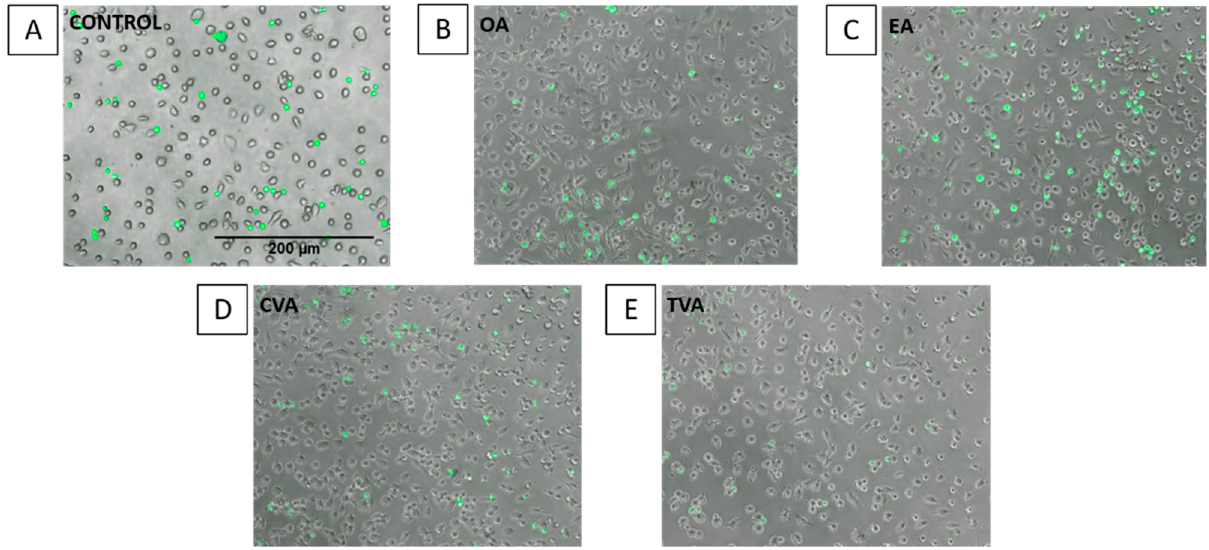
Figure 7. Images of THP-1 cell adhesion to EA.hy926 cells. Adhesion of THP-1 cells to EA.hy926 cells without preincubation with FA (control ( A )) or with 48 h prior exposure to 50 μ M oleic acid ( B ), elaidic acid ( C ), cis vaccenic acid ( D ), or trans vaccenic acid ( E ), followed by incubation with TNF- α (1 ng/mL) for 6 h and then 1 h co-incubation with calcein-labelled THP-1 cells. Attached THP-1 cells were visualised by fluorescence microscopy (Nikon Elipse Ti) at a magnification of 100 × under transmitted light.